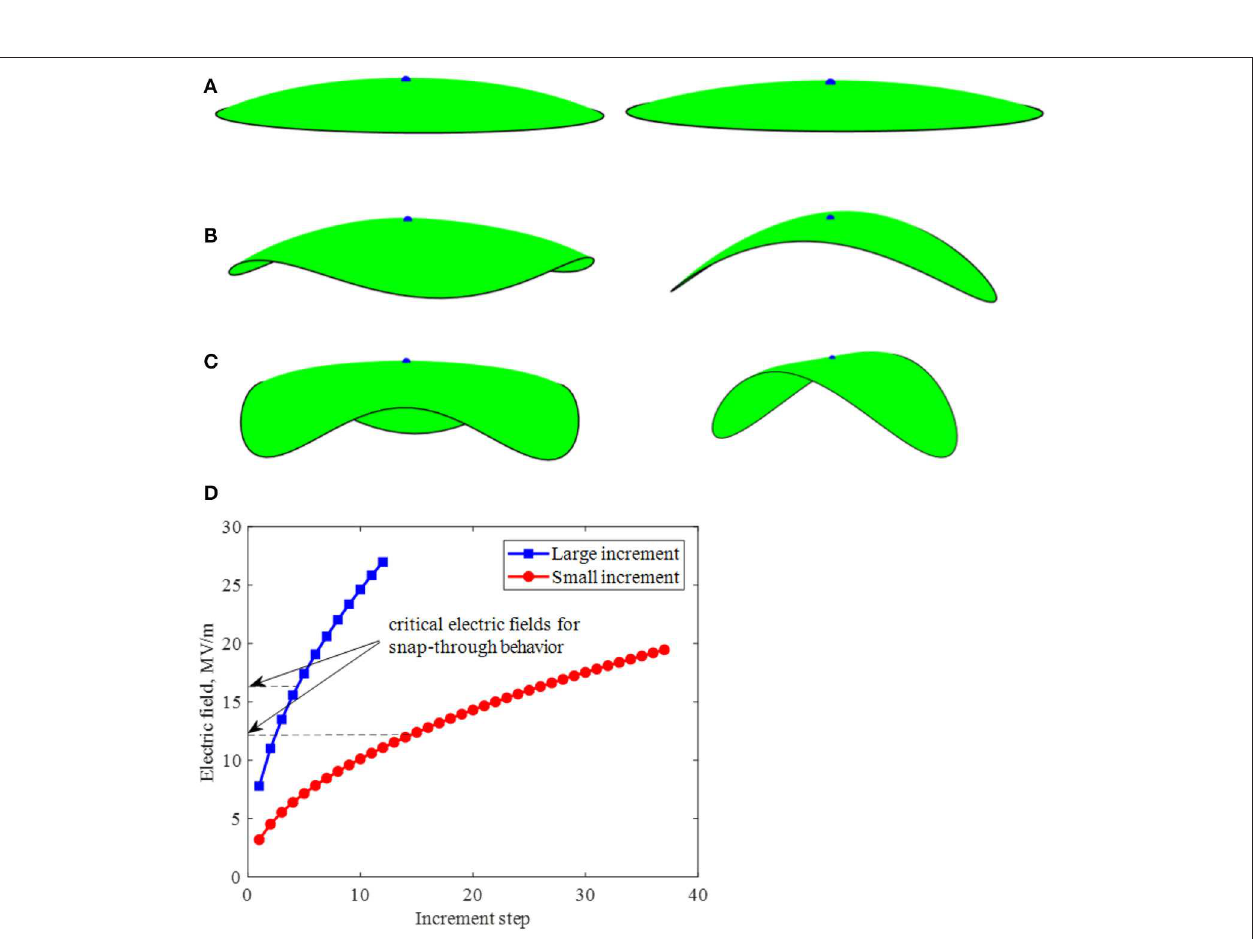
FIGURE 12 | Folding of disk shape plate. Left: with large electric field increment; Right: with small electric field increment. (A) Electric field 11 MV/m; (B) electric field 17 MV/m; (C) electric field 19 MV/m; and (D) critical electric fields for the snap-through behavior under different increment.